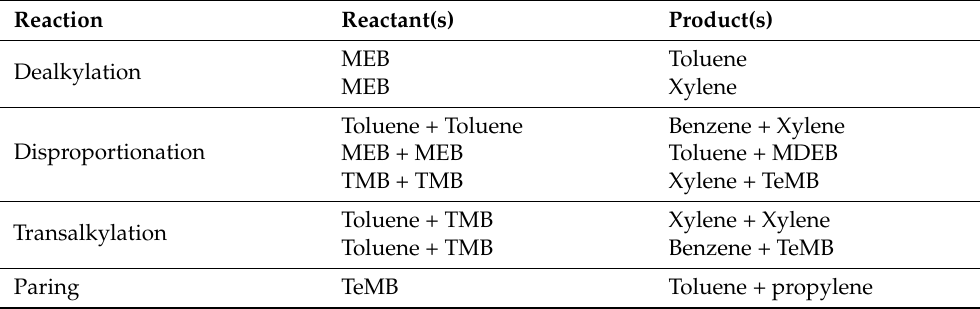
Table 2. Key reactions during the conversion of heavy reformate to xylenes.